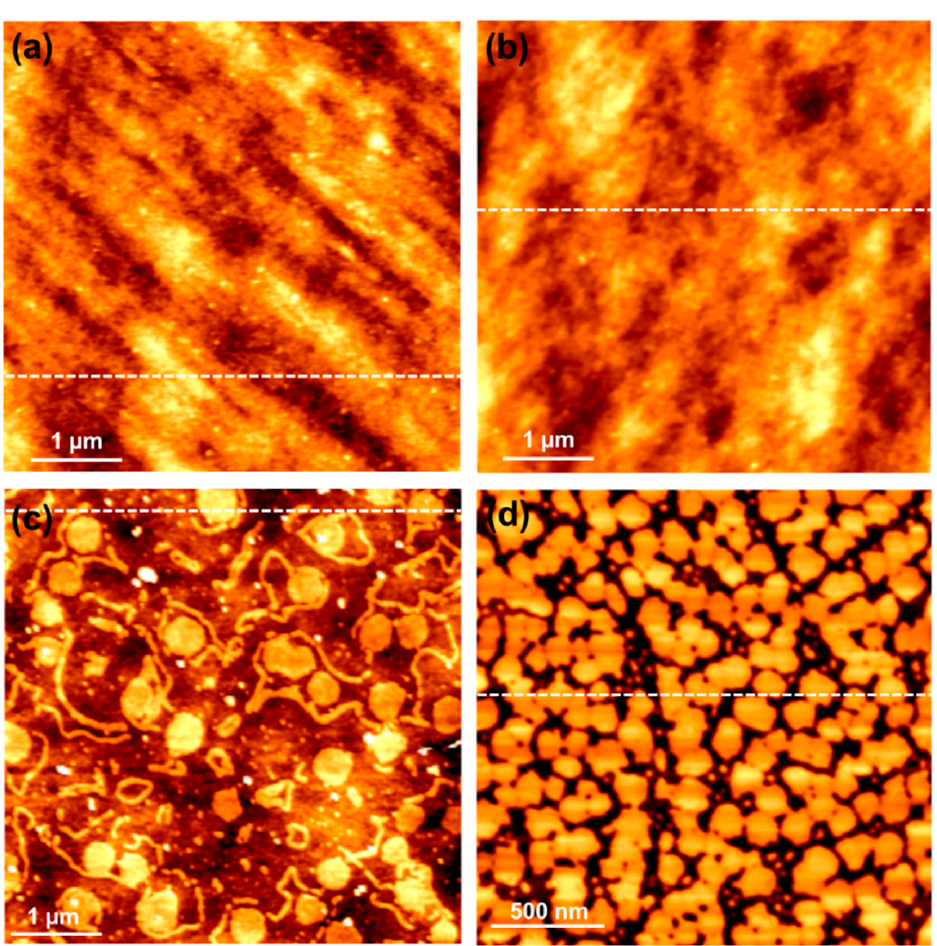
Figure 2. AFM topographic images for a bare SiO 2 substrate ( a ); OTMS SAMs with complete coverage prepared on a UV/ozone-treated SiO 2 substrate ( b ); OTMS SAMs with partial coverage formed on a UV/ozone-treated SiO 2 substrate ( c ); a freshly cleaved mica substrate ( d ). The broken line shown in each image indicates where a profile is isolated (and shown in Figure 3). The scan areas for ( a – d ) are 5 µm × 5 µm and 2 µm × 2 µm, respectively. The heights for ( a ‒ d ) are 2.88, 3.02, 18.41 and 2.07 nm, respectively.